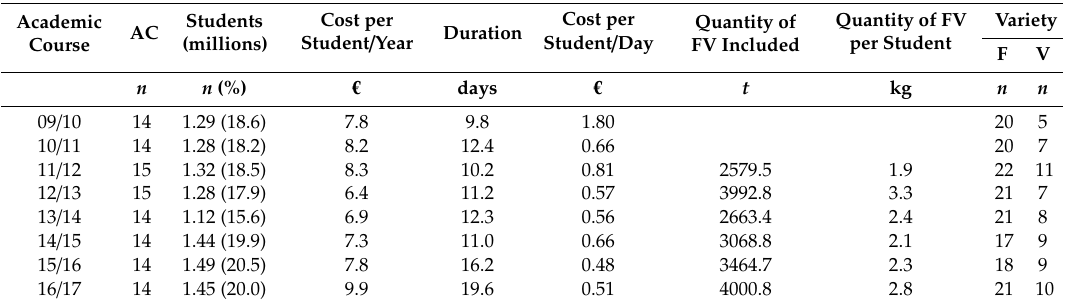
Table 1. Characteristics of the School Fruit and Vegetables Scheme in Spain: averages for the 2009–2017